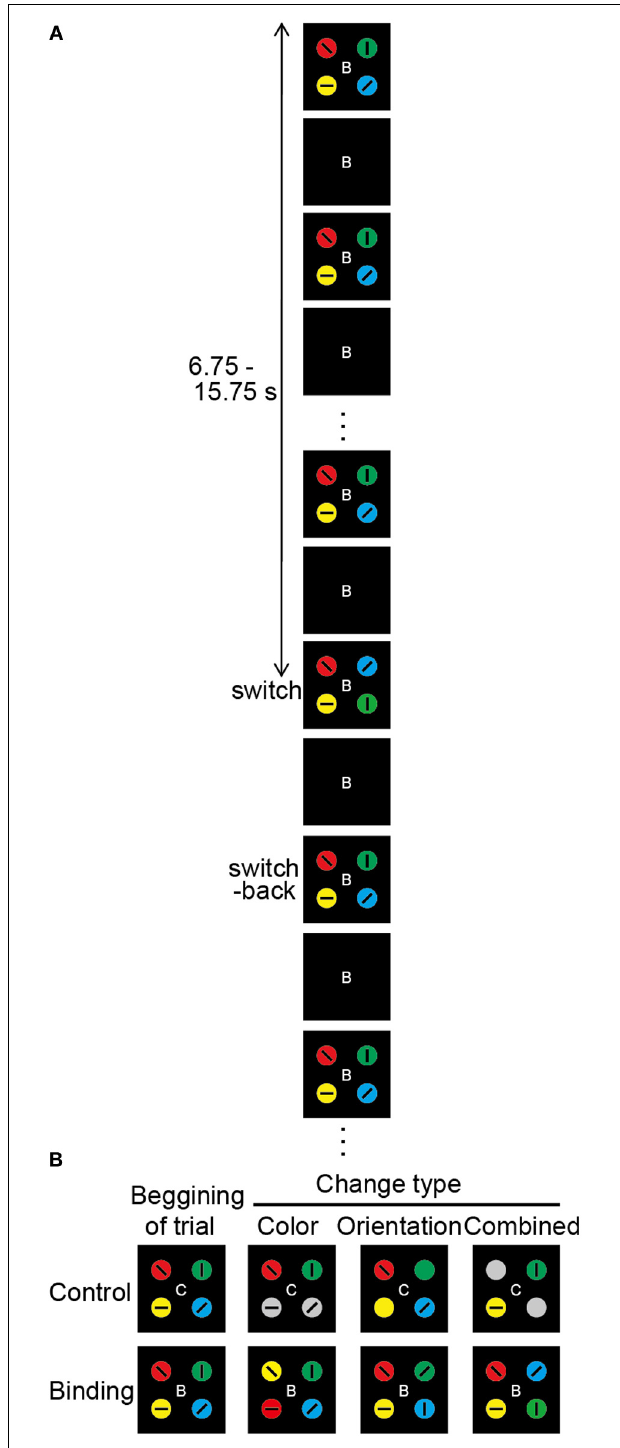
FIGURE 1 | Overview of the change detection task. (A) Schematic diagram of the change detection task (combined binding change). At the beginning of each trial, the occluder, and the capitalized letter (B or C) at the center of the visual stimuli are presented for 500ms. Then, the occluder begins to move. The targets gradually appear, become gradually occluded, and gradually reappear, which repeats until the end of the trial.